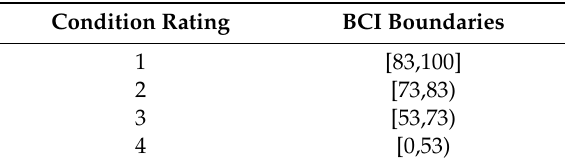
Table 1. Bridge Condition Index (BCI) boundaries for the four condition